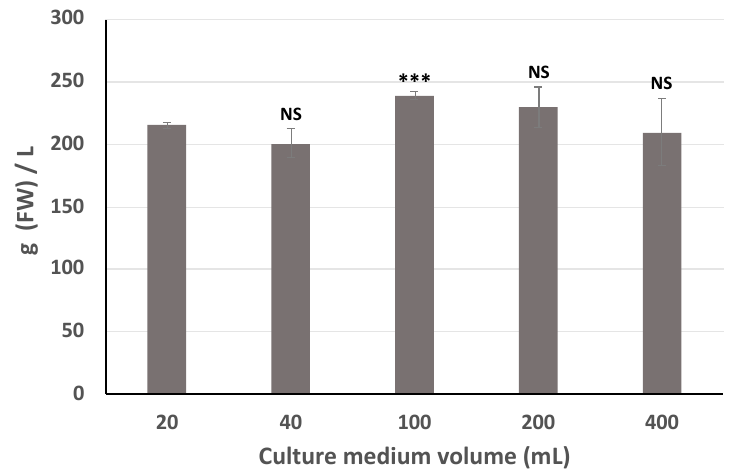
Figure 2. Scaling-up of chicory hairy root culture in Erlenmeyer flasks; Fresh weight (FW) was estimated on day14. Statistics were achieved by a two-tailed t test using Prism GraphPad online tool ( https://www.graphpad.com/quickcalcs/ttest1/ ). The mean with SD were calculated and plotted. *** p = 0.0001 to 0.001; NS (Not Significant), p ≥ 0.05. All the conditions were compared to the 20 mL condition.